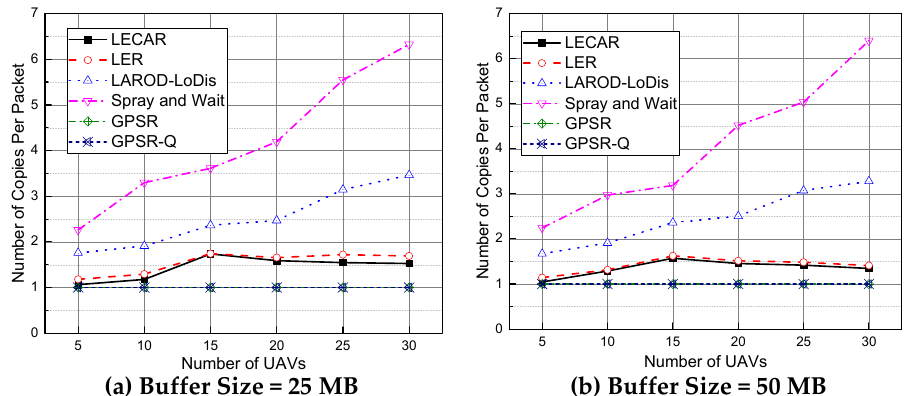
Figure 13. Performance comparison of the routing protocols regarding the number of copies per packet when the buffer size is ( a ) 25 MB and ( b ) 50 MB.